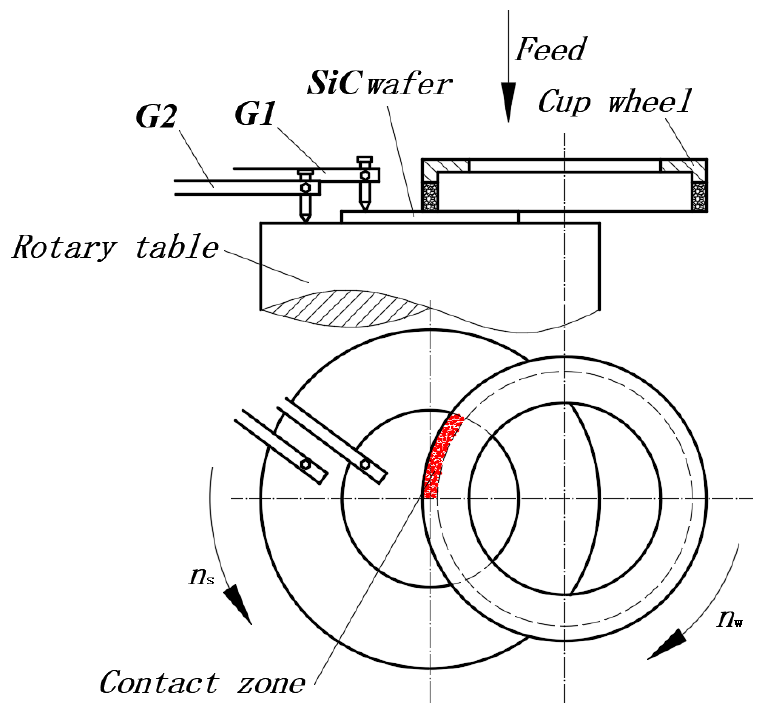
Figure 1. Principle of workpiece rotation grinding. Table 1. Grinding conditions used in experiments.